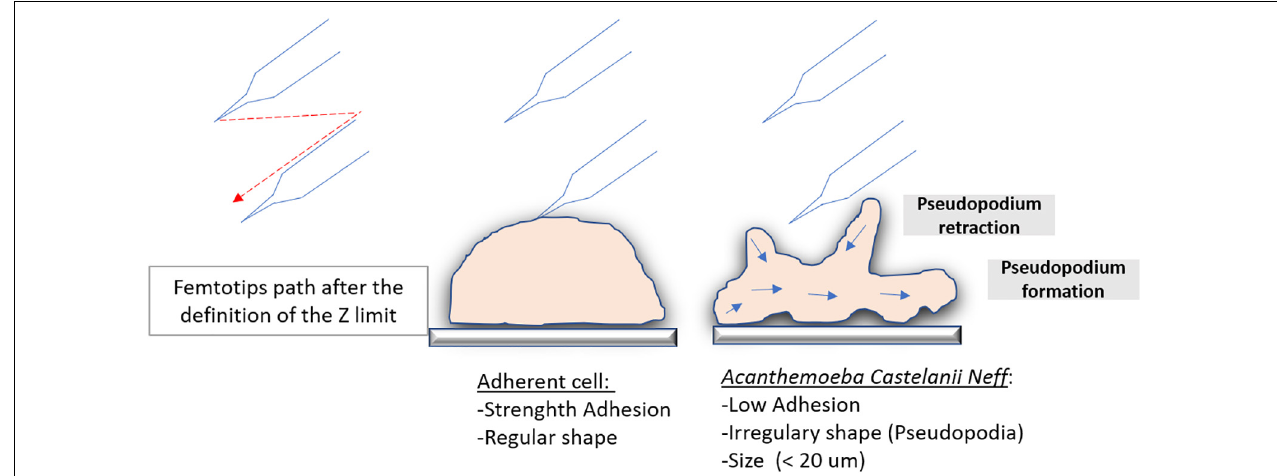
FIGURE 7 | Microinjection difference on highly adherent cells and on amoeba. Schematic illustration of the trajectory comparison of the femtotips on a highly adherent cell and on an amoeba that is a less adherent cell during the initiation of the microinjection.